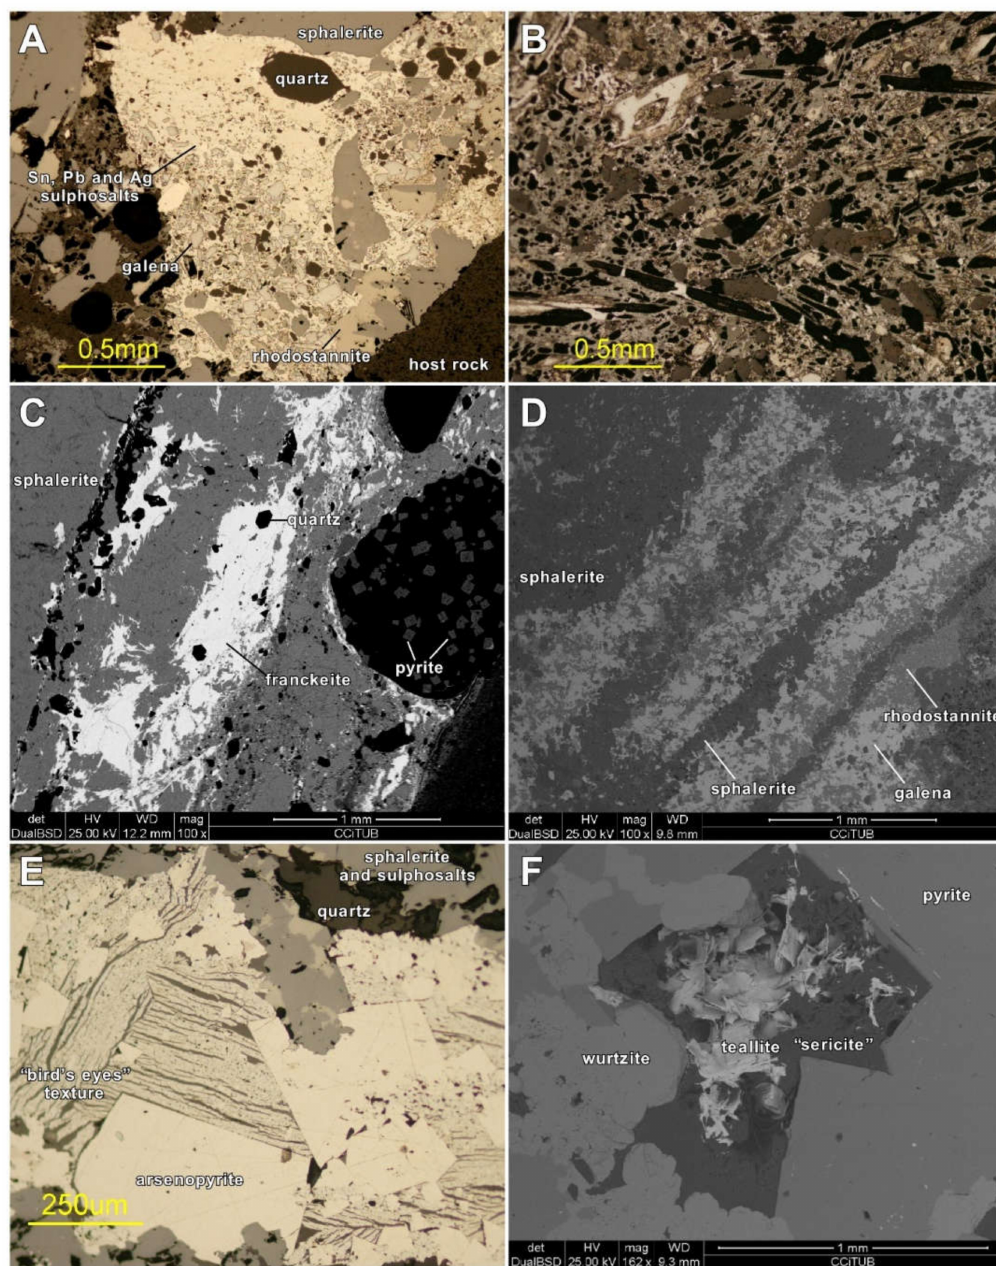
Figure 4. Photomicrographs and back-scattered electron images of selected textural features in the Poop ó deposit. ( A , B ) Microbrecciation in hydrothermal ore-bearing associations cemented by tin and silver sulphosalts of Stages 2 and 3; polarised reflected light. For the complete mineralogy of cementing Sn, Pb and Ag sulfosalts, see Figure 9. ( C ) Detail of brecciated material cemented by Stage-2 sulphides and sulphosalts; notice the rounded fragments of earlier vein material; back-scattered electron image. ( D ) Cyclic micro-banding textures in ore associations of Stage 2; back-scattered electron image. ( E ) Arsenopyrite → pyrrhotite → pyrite → sphalerite + sulphosalts succession with the development of “bird’s eyes” textures due to the replacement of pyrrhotite by pyrite and mascasite; all the sequence is reactive except for the precipitation of pyrrhotite on arsenopyrite; polarised reflected light. ( F ) Teallite and “sericite” in micro-cavities after the precipitation of pyrite and wurtzite (reactive); back-scattered electron